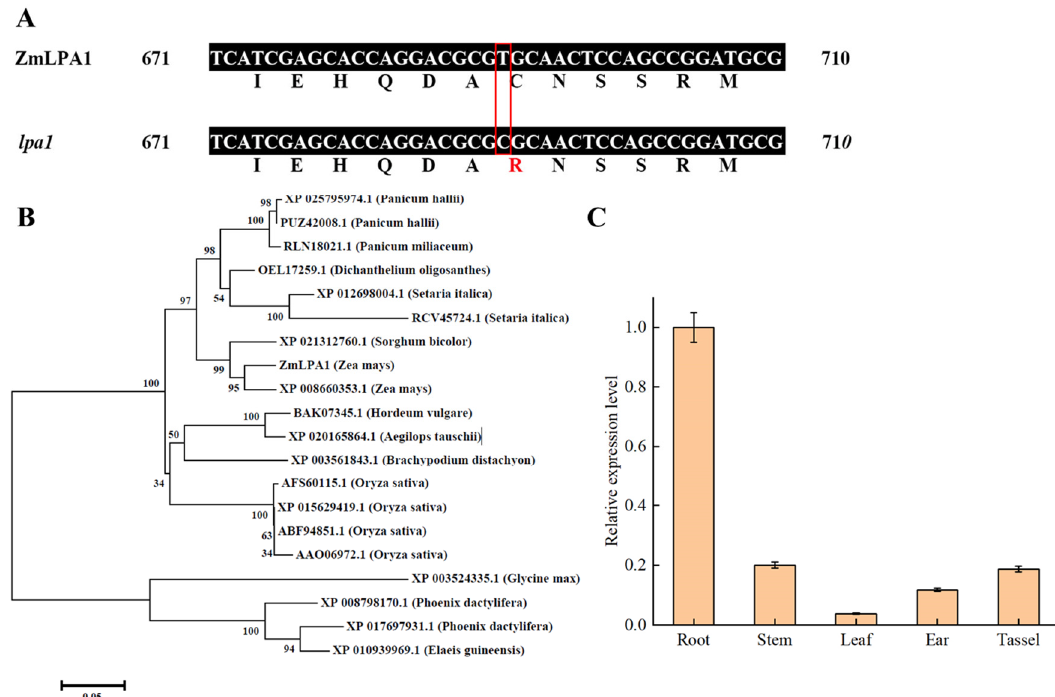
Figure 1. Analysis of ZmLPA1 gene in maize. ( A ) Alignment of ZmLPA1 gene cDNA sequences in B73 and lpa1 , amino acid changes are marked with red box; ( B ) Phylogenetic tree of ZmLPA1 gene; ( C ) Transcription expression of ZmLPA1 gene in different tissues of maize.